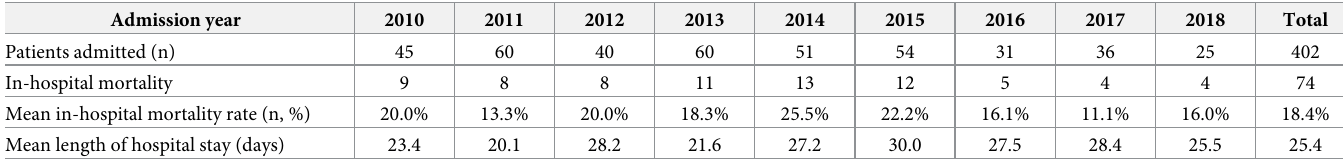
Table 1. Total patients with hip fracture admitted, mean in-hospital mortality rate and mean length of hospital per year.